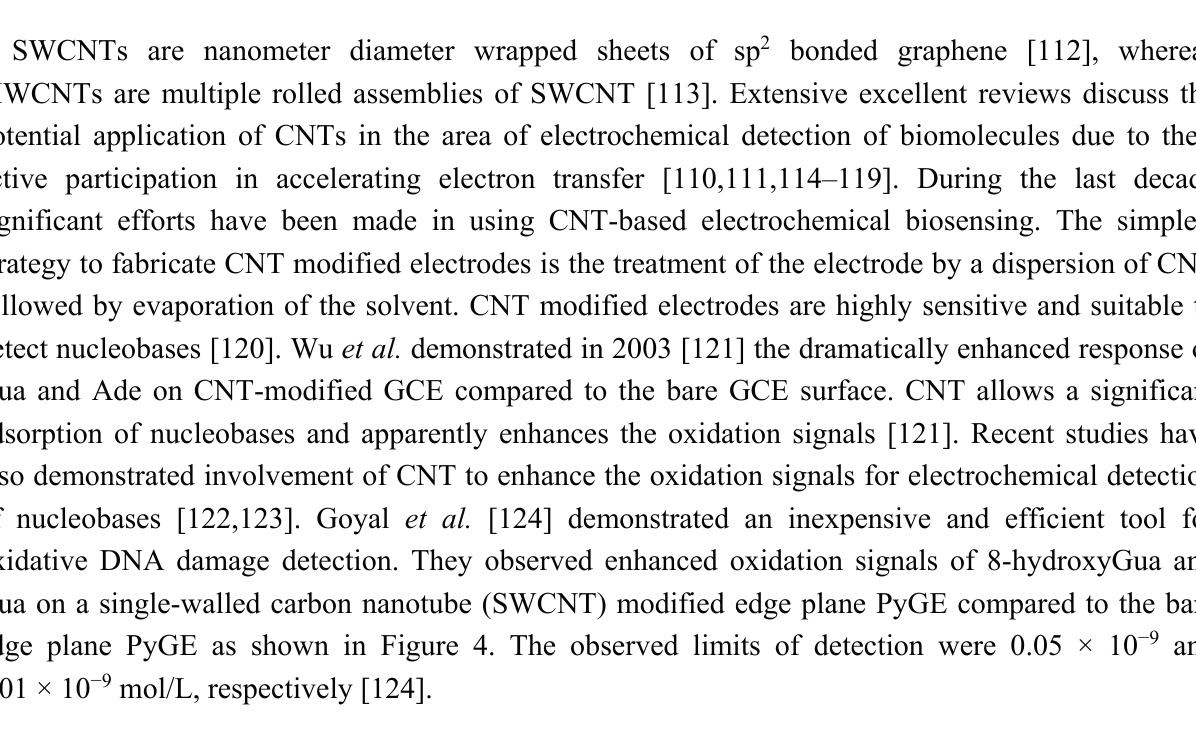
Figure 3. Schematic representation of ( A ) single-walled carbon nanotubes (SWCNT) and ( B ) multi-walled carbon nanotubes